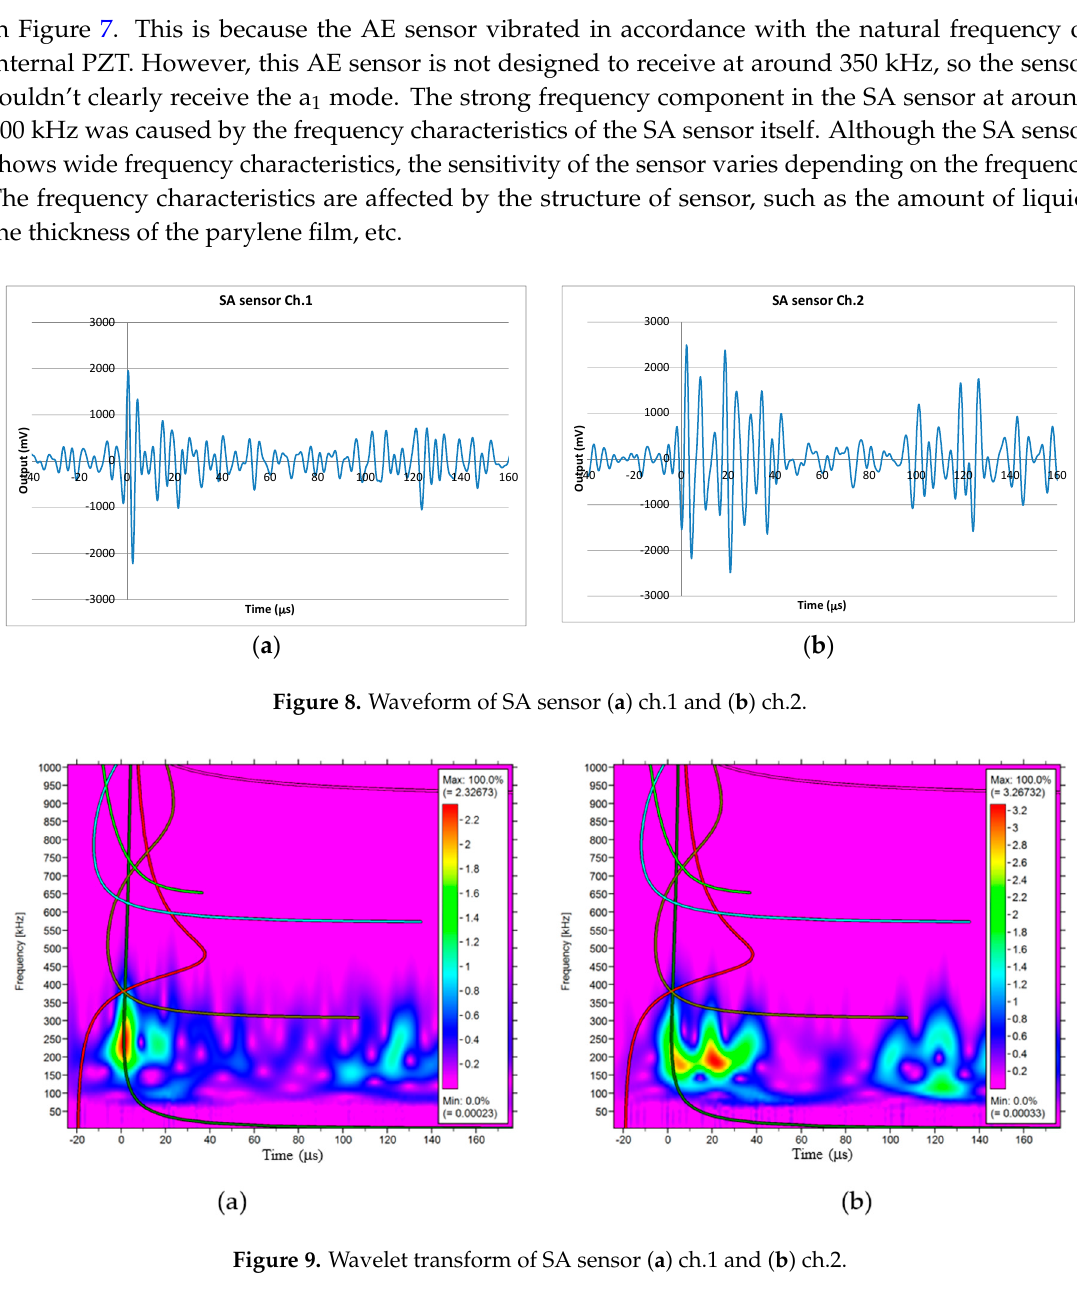
Figure 9. Wavelet transform of SA sensor ( a ) ch.1 and ( b ) ch.2.